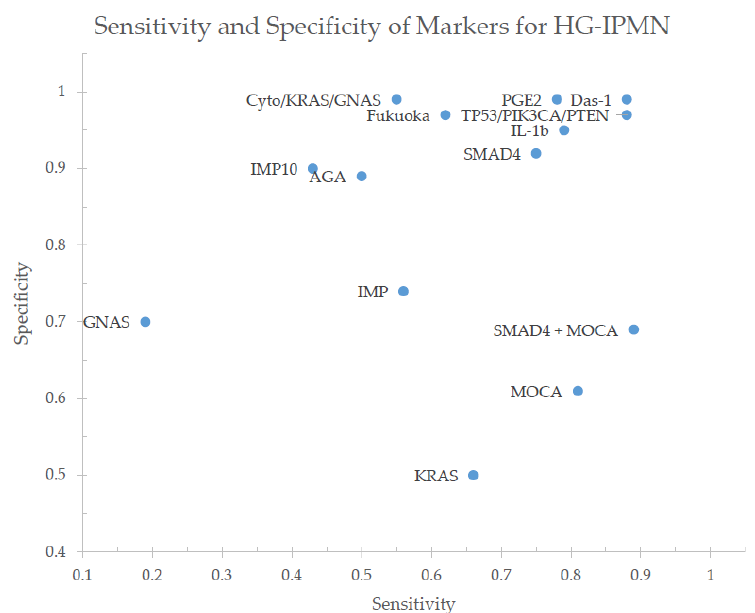
Figure 2. Sensitivities and specificities of the single-marker and composite-marker analyses identifying high-grade and invasive intraductal papillary mucinous neoplasm (IPMN) as provided by the discussed studies